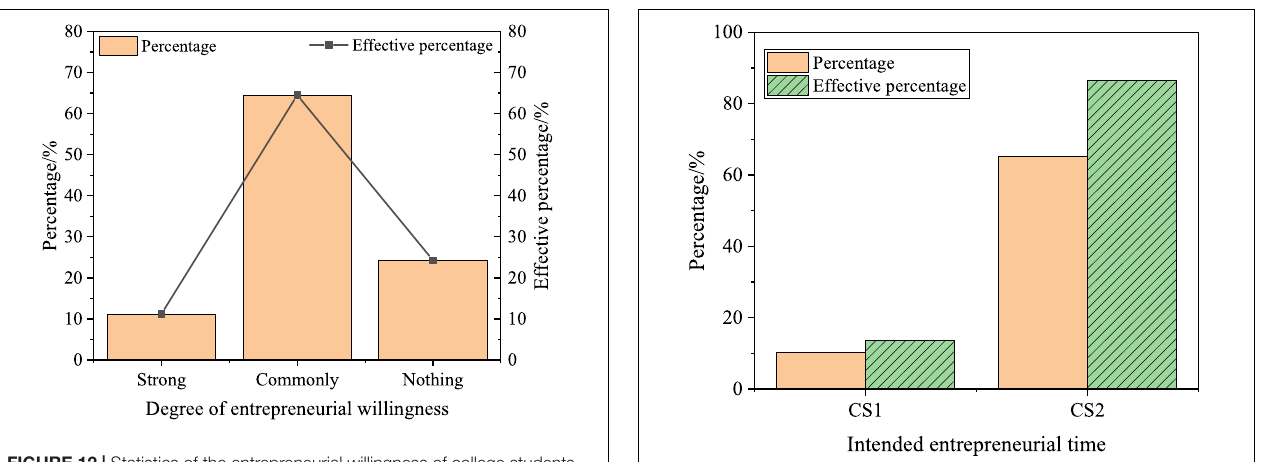
FIGURE 12 | Statistics of the entrepreneurial willingness of college students.